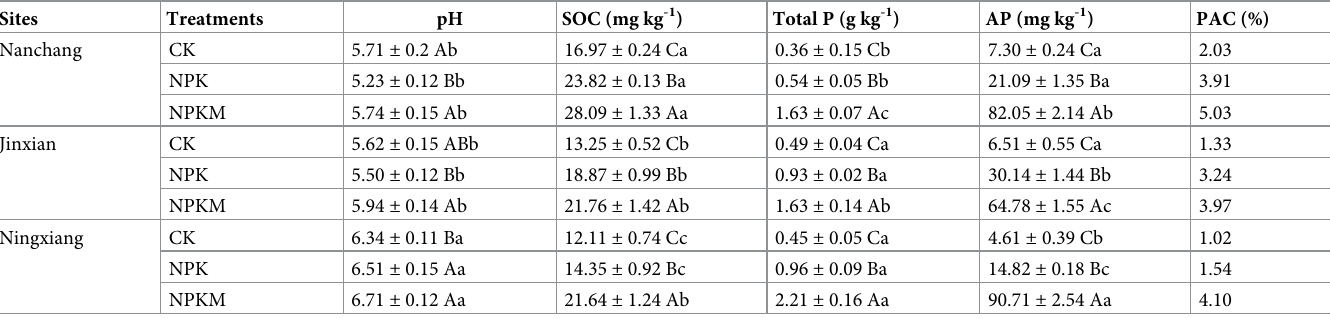
Table 3. The effect of long-term fertilization on soil pH, SOC, total P and available P concentrations and PAC. Sites